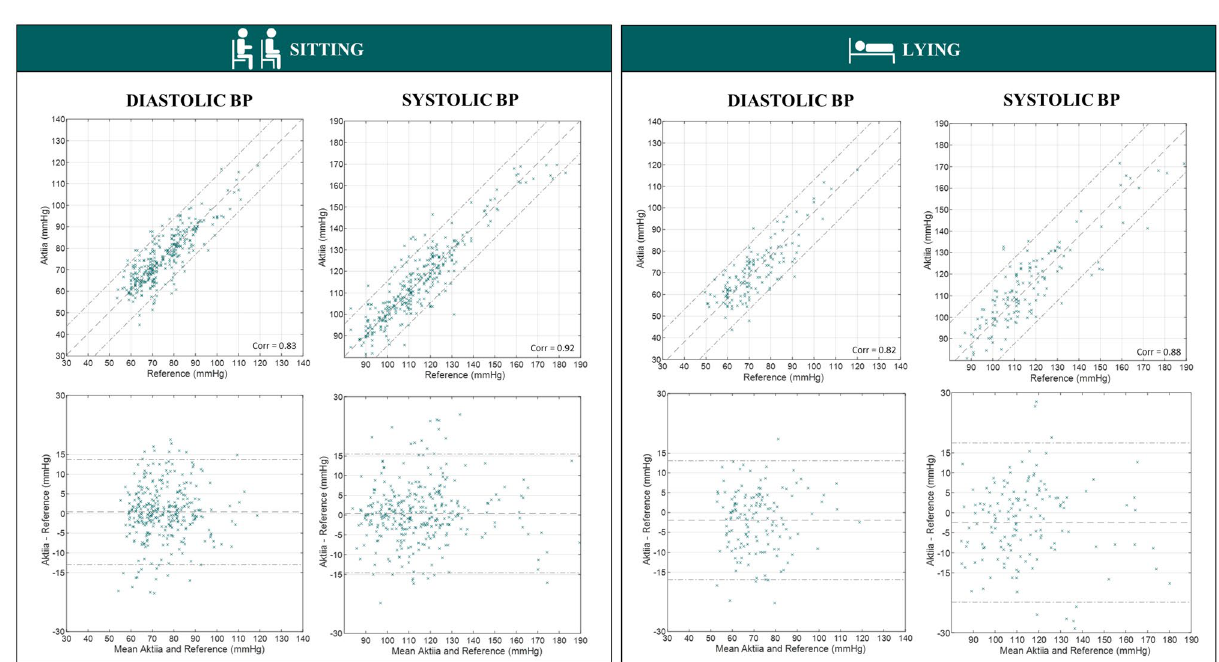
Figure 6. Scatter plots and Bland Altman plots comparing Aktiia BP readings against reference auscultatory readings for sitting and lying